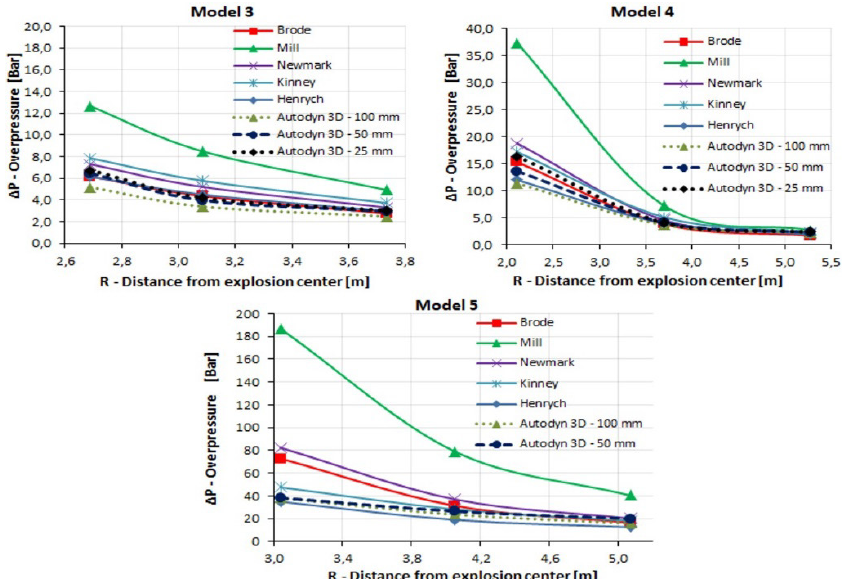
Figure 11. Overpressure peaks in gauges 1, 2, and 3 for models 3 to 5.